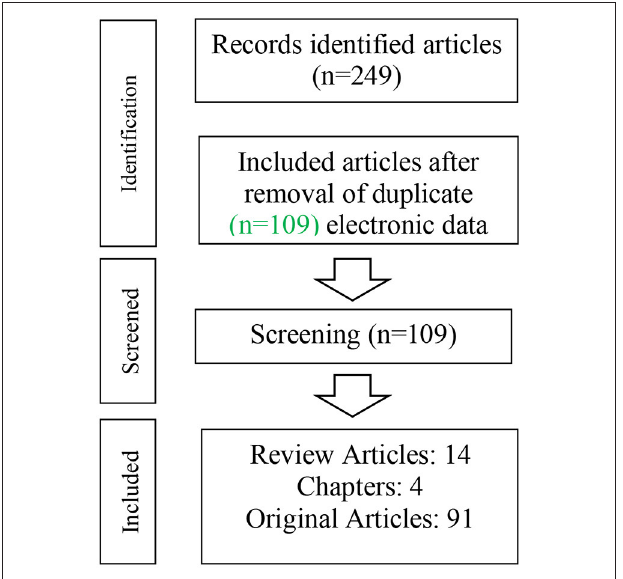
FIGURE 1 | Flowchart of the process of selecting studies for